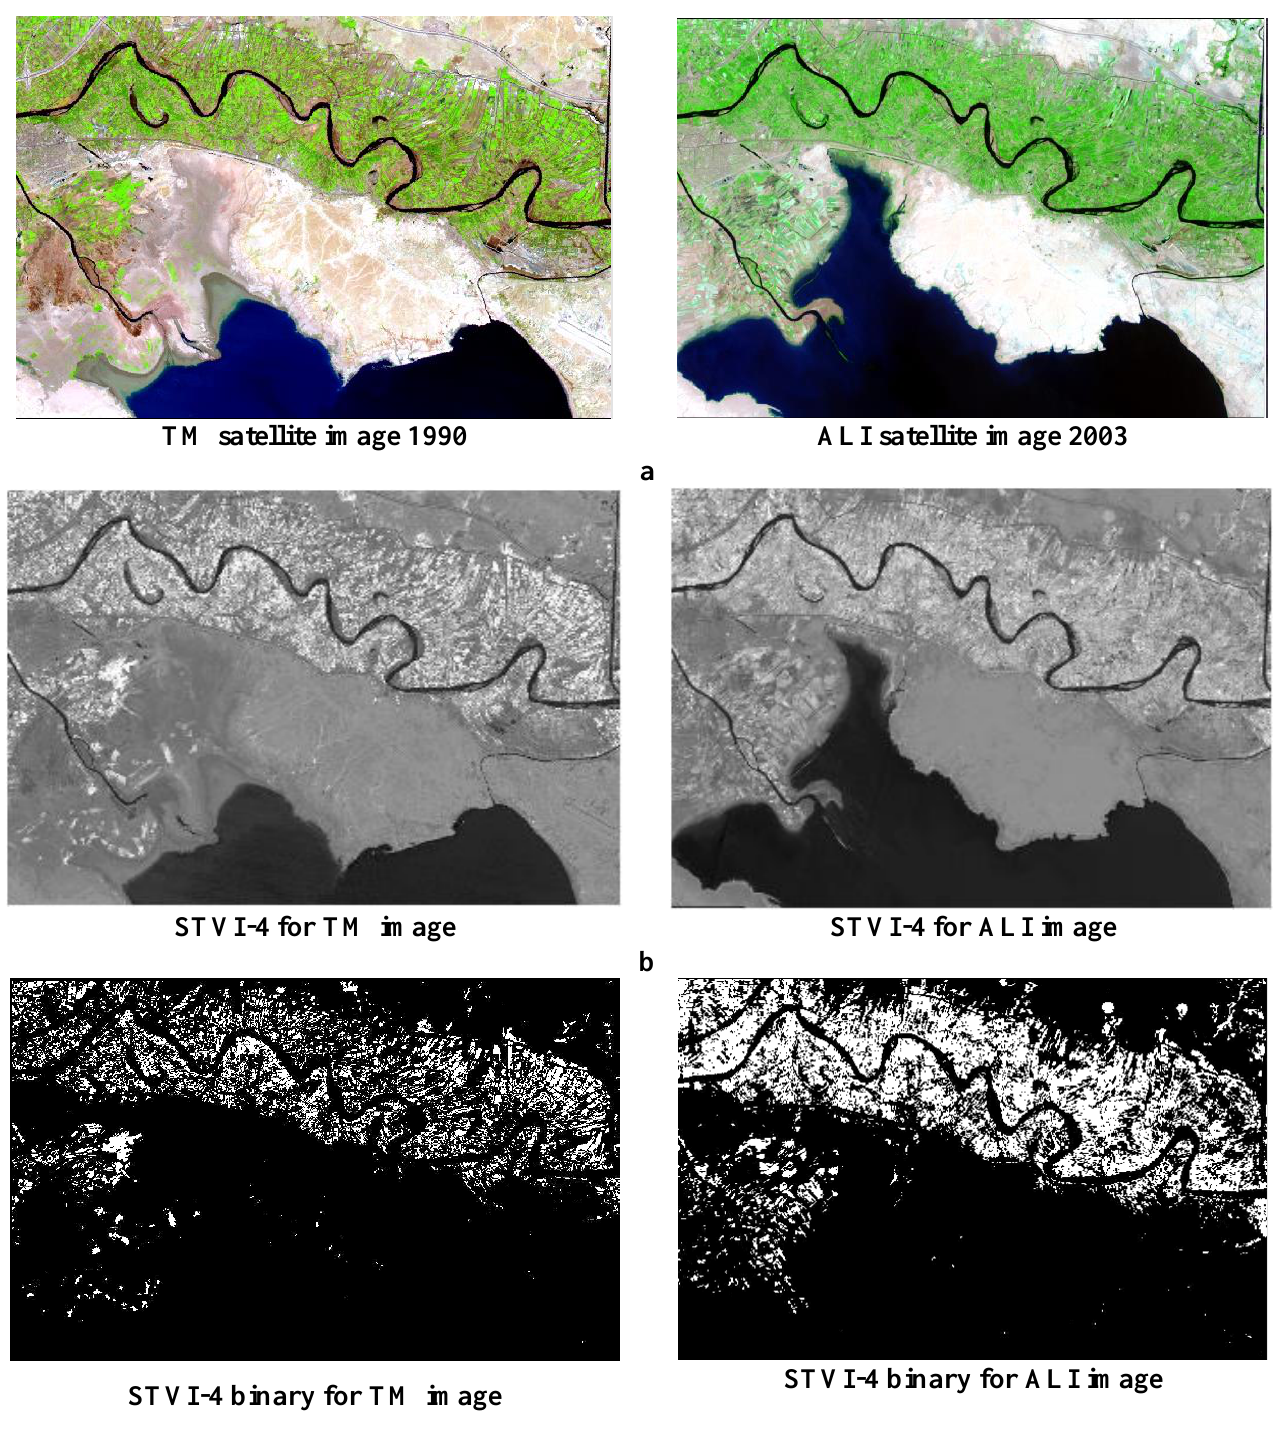
Fig.1: a- muilt-temporal a Ramadi city for landsat TM & Geo-Crrected EO-1 ALI, in years 1990, and 2003 (each of size 738 × 1027 Pixels), b, e, & f- the vegetation indices ( STVI-4, STVI-1 & STVI-3) effects on the multi- temporal images (1990 and 2003), c- vegetation layers, binaries by (decided threshold =185) for STVI-4 index, d- The changes in vegetation layers, using differencing images method between STVI-4 binaries